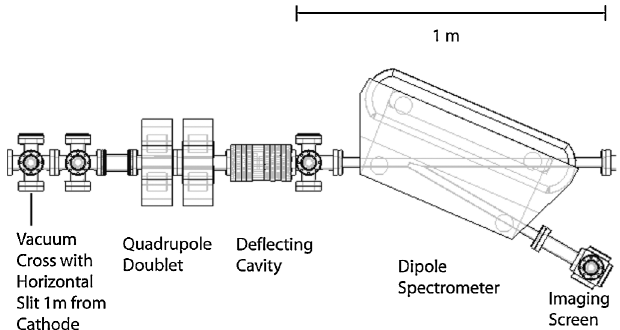
FIG. 1. Top down view of the Pegasus LPS measurement beam line section. The beam is sliced, focused, deflected, dispersed, and finally